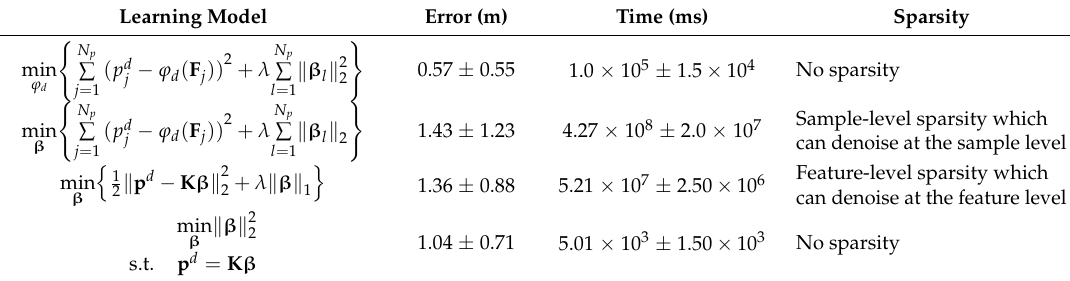
Table 1. The relationship between the proposed four learning